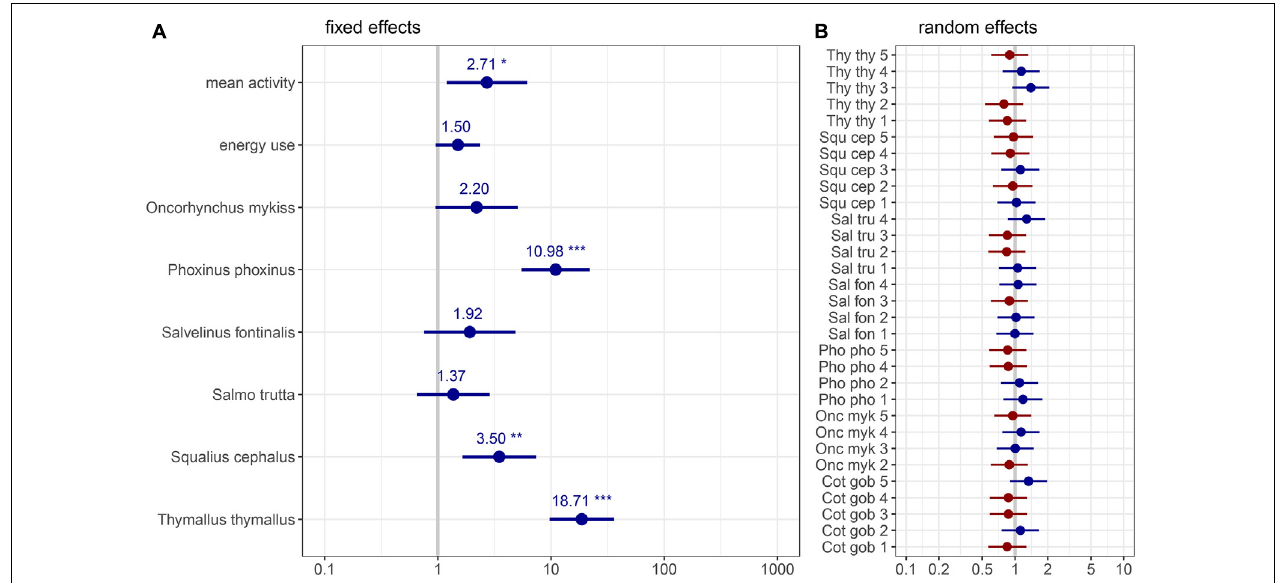
FIGURE 4 | Graphic representation of the GLMM estimates (model #3) best describing the obtained target eDNA copy numbers: (A) fixed effects and (B) random effect of individual fish. Coefficients are exponentiated, significance codes of denoted fish species indicate differences in comparison to the base category Cottus gobio , whiskers display the 95%-CI. Fish species are abbreviated: “Cot gob,” Cottus gobio ; “Onc myk,” Oncorhynchus mykiss ; “Pho pho,” Phoxinus phoxinus ; “Sal fon,” Salvelinus fontinalis ; “Sal tru,” Salmo trutta ; “Squ cep,” Squalius cephalus ; “Thy thy,” Thymallus thymallus in addition to individual numbers from 1 to 5. Asterisks denote p -values smaller than: 0.05 (*), 0.01 (**), and 0.001 (***).